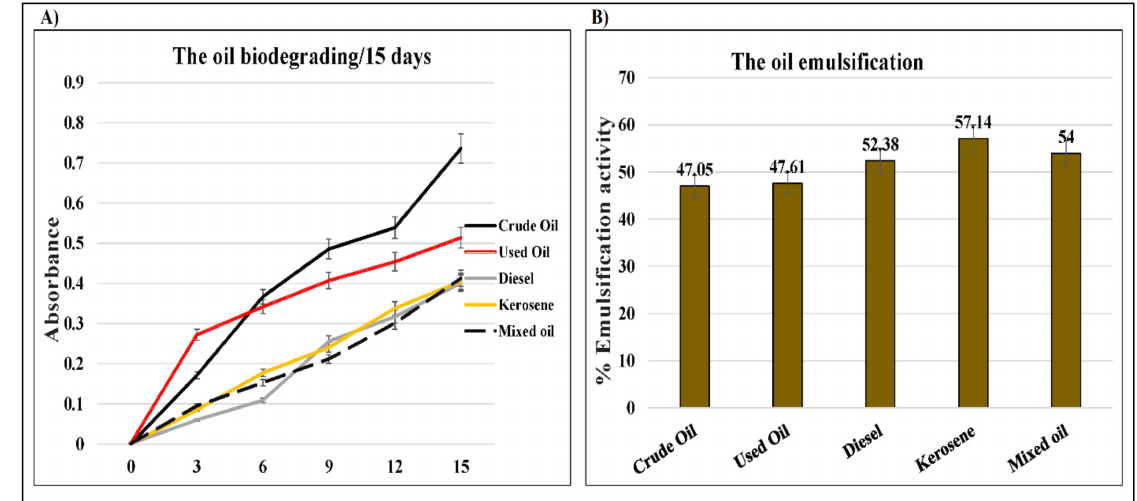
Figure 4. Biodegradation ability of D. spicifera. The fungal growth effects on the physical charac- teristics of tested hydrocarbons were evaluated with 1% of each oil. ( A ) DCPIP assay for 15 days, ( B ) percentage of emulsification activity.